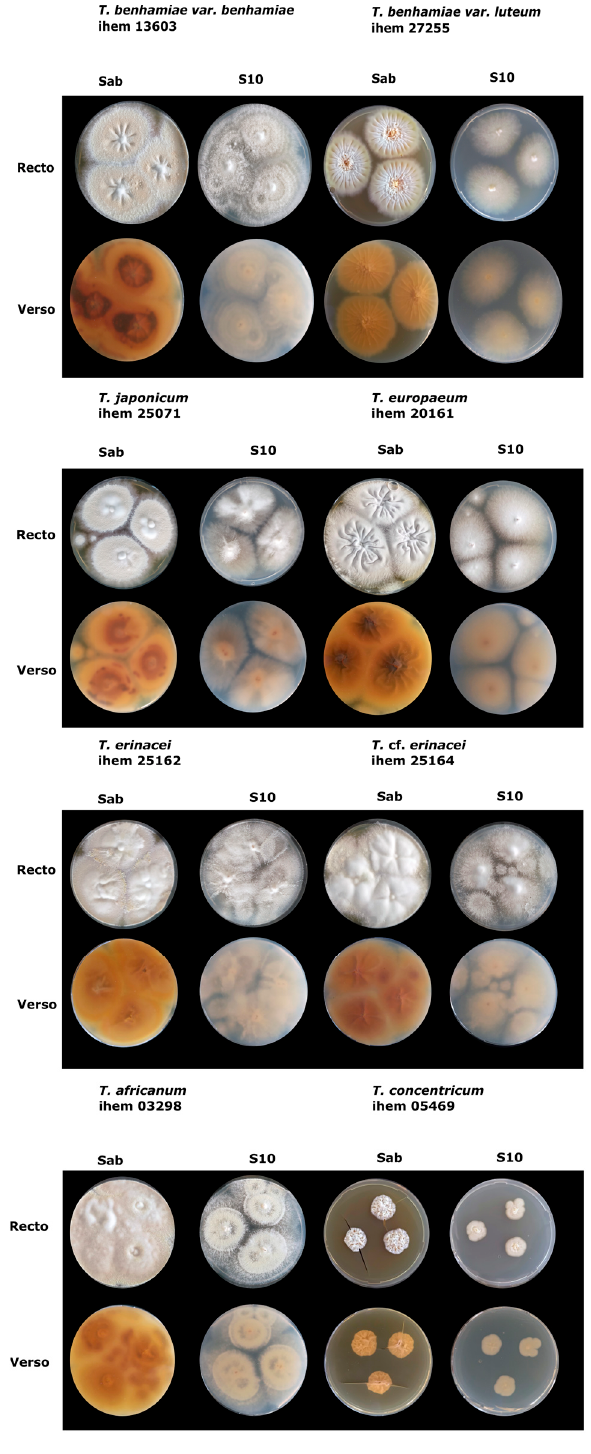
Figure 2. Pictures illustrating the macromophology of strains representative of T. benhamiae var. benhamiae (IHEM 13603), T. benhamiae var. luteum (IHEM 27255), T. japonicum (IHEM 25071), T. europaeum (IHEM 20161), T. erinacei (IHEM 25162), T. cf. erinacei (IHEM 25164), T. africanum (IHEM 03298), and T. concentricum (IHEM 05469). Isolates were incubated for 14 days on Sabouraud